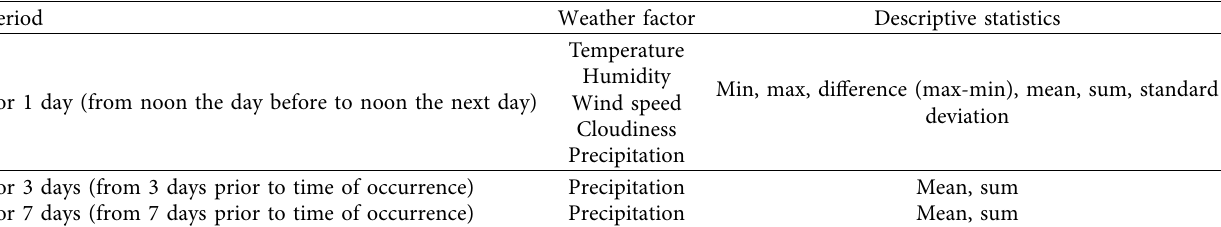
Table 2: Derived variables.